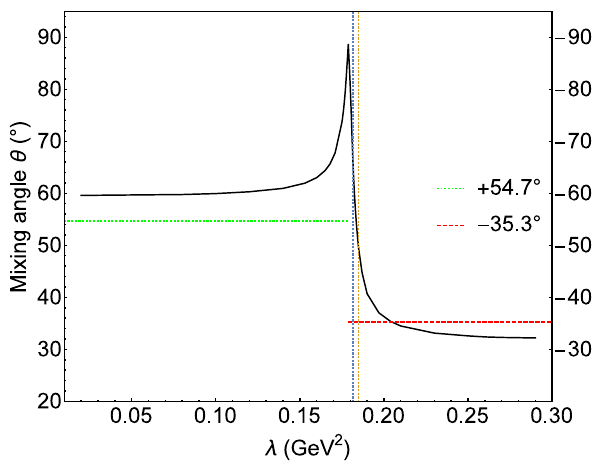
Fig. 1 The calculated mixing angle θ along with the parameter λ . Where θ > 0 with λ < 0 . 1788 GeV 2 , while θ < 0 when λ > 0 . 1788 GeV 2 . Between the blue and orange dotted lines is the range of our best